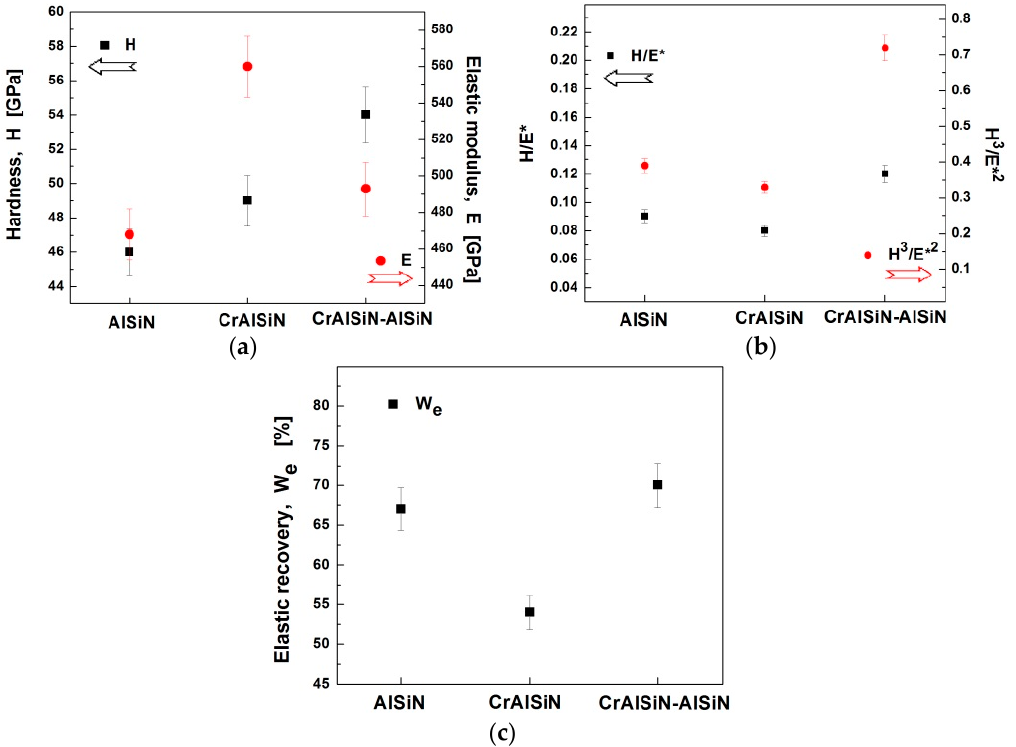
Figure 5. Comparison of the mechanical properties of CrAlSiN–AlSiN, CrAlSiN, and AlSiN coatings: ( a ) hardness and an elastic modulus; ( b ) elastic strain to failure and resistance to plastic deformation; ( c ) elastic recovery.